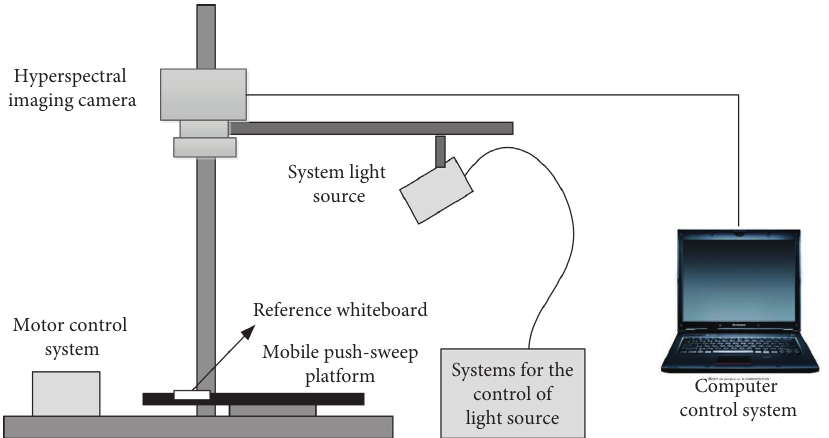
Figure 2: Push-sweep (reflective grating) hyperspectral imaging